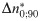
Polarization-phase spatial distribution PT(m×n) and histograms N(PT) of the distributions Φ(m×n) and A(m×n) of myocardium histological sections of deceased patients from the group 1 (Δn0;90, Δn⊗;⊕, Δμ0;90, Δμ⊗;⊕) and the group 2 (Δn0;90*, Δn⊗;⊕*, Δμ0;90*, Δμ⊗;⊕*).